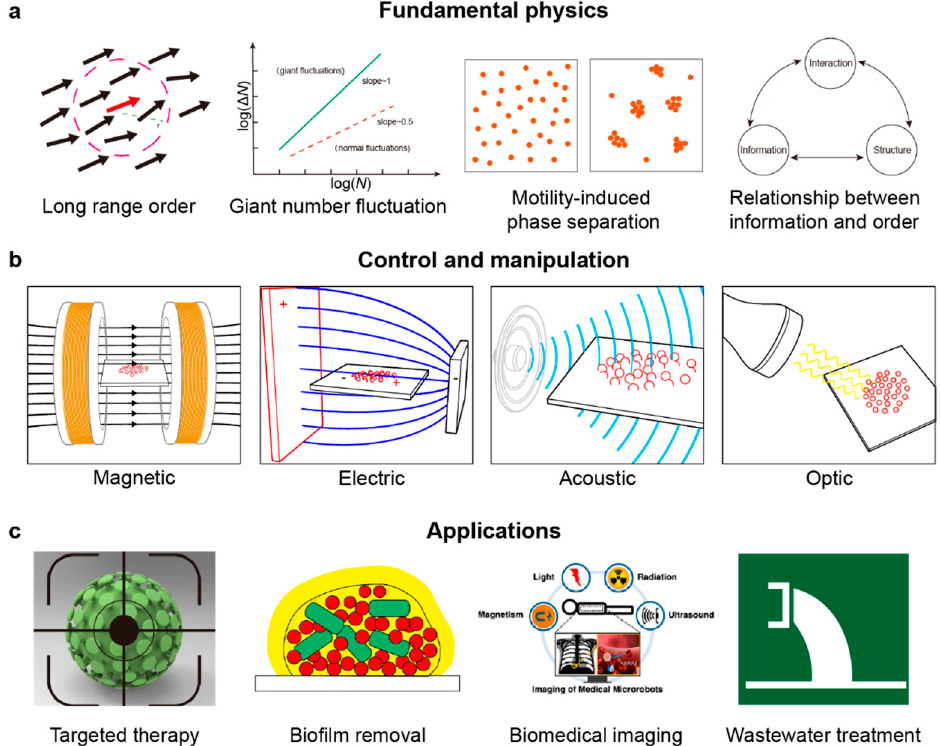
Figure 1. Overview of the perspective of fundamental physics, manipulation, and applications of microscopic swarms. ( a ) Schematic representing fundamental physics of active matter systems. ( b ) Schematic of different control and manipulation methods. ( c ) Application fields of microscopic swarms in biomedicine and the environment.